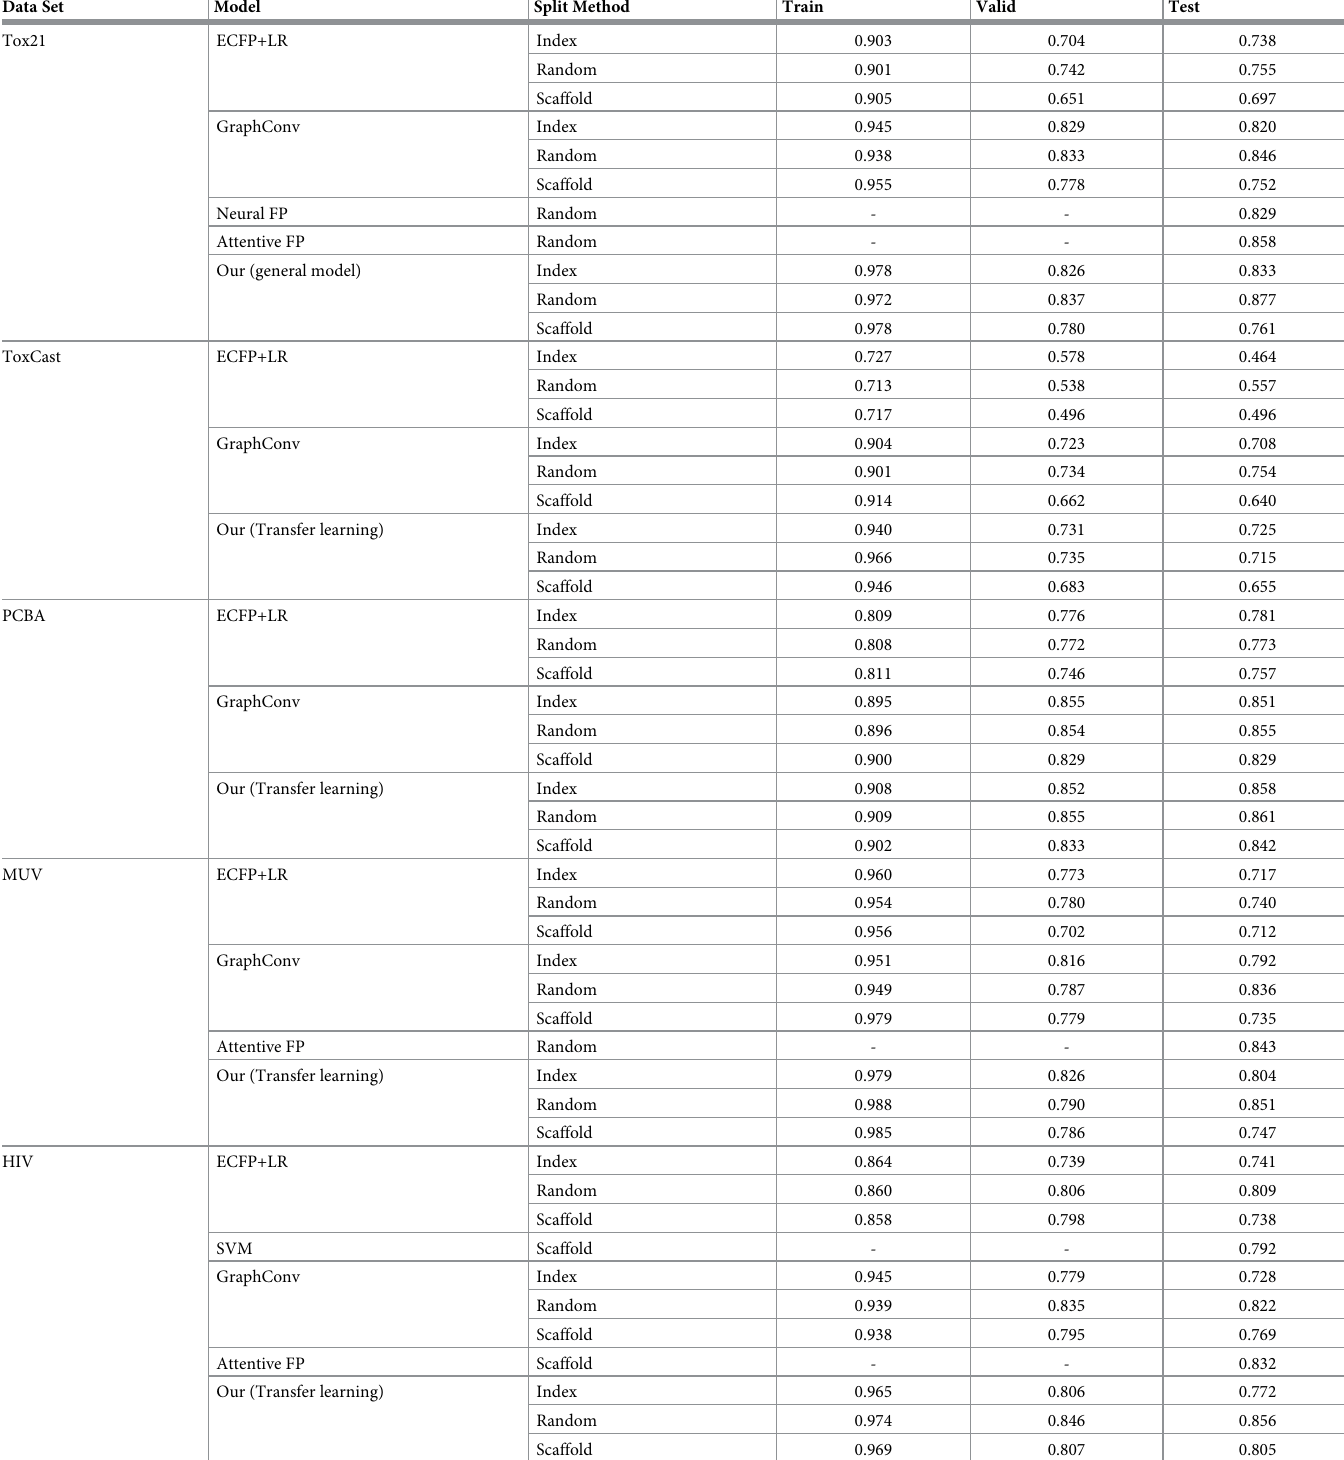
Table 1. The area under curve (AUC) of the ROC curve of various models in Tox21, ToxCast, MUV and HIV data sets. Data